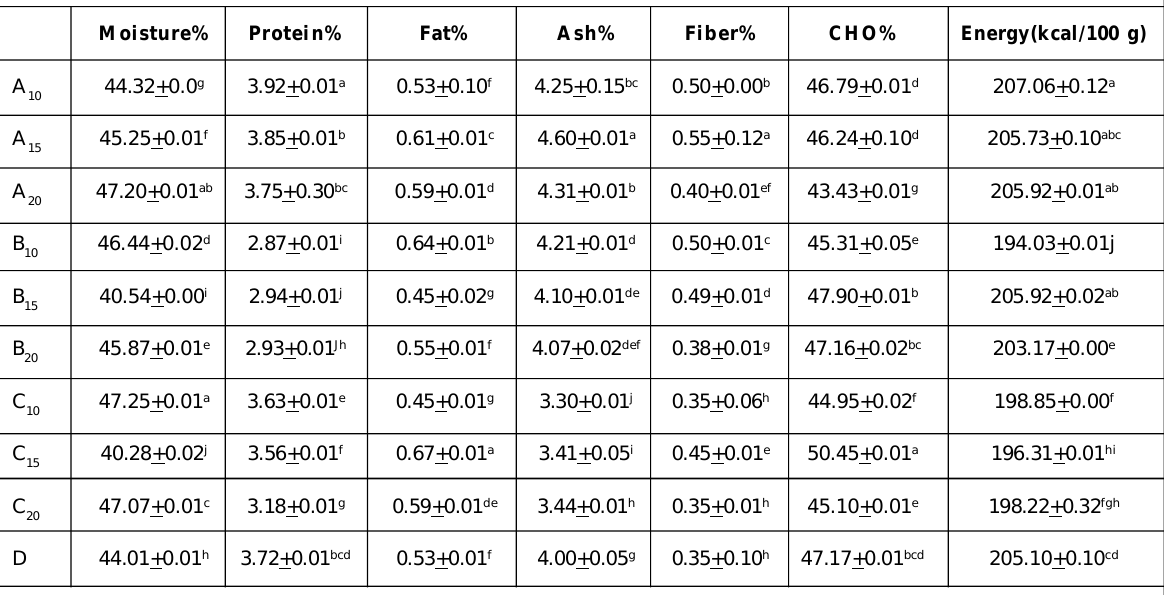
Table 2: Proximate composition of partially fortified yogurt with different variety of banana